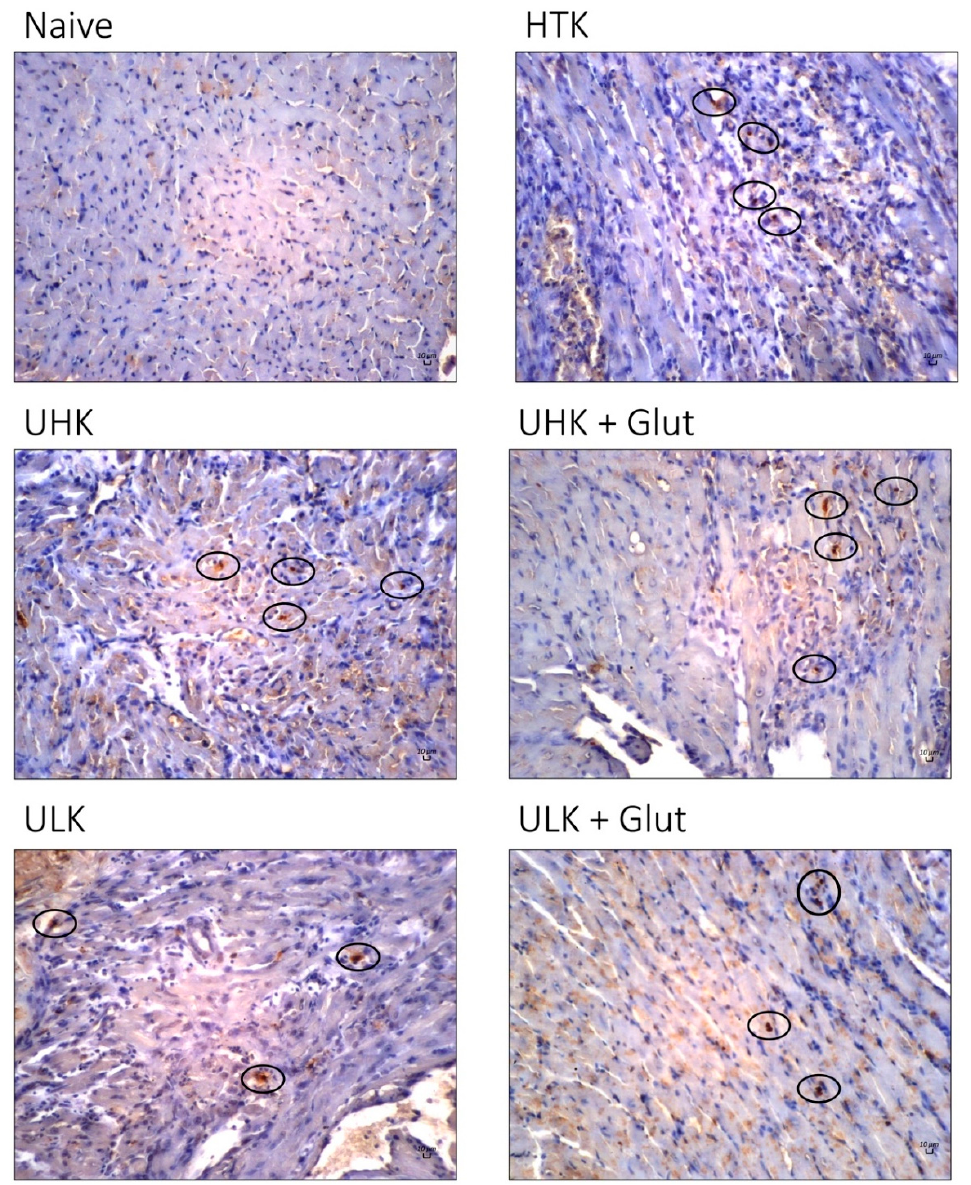
Figure 5. Representative images of TUNEL staining of cardiac tissue sections taken on POD three after heterotopic heart transplantation (scale bar 10 µm; 20× magnification). Compared to naïve cardiac tissue, all experimental groups displayed significantly increased numbers of TUNEL + cells (dark cells marked with black circles) in graft biopsies. Unisol, gluconate-lactobionate-dextran; HTK, histidine-tryptophan ketoglutarate solution; UHK, Unisol-high-potassium; ULK, Unisol-low-potassium; Glut, glutathione.